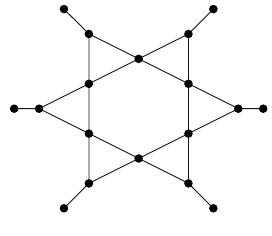
Fig. 1 A graph G ∈ A